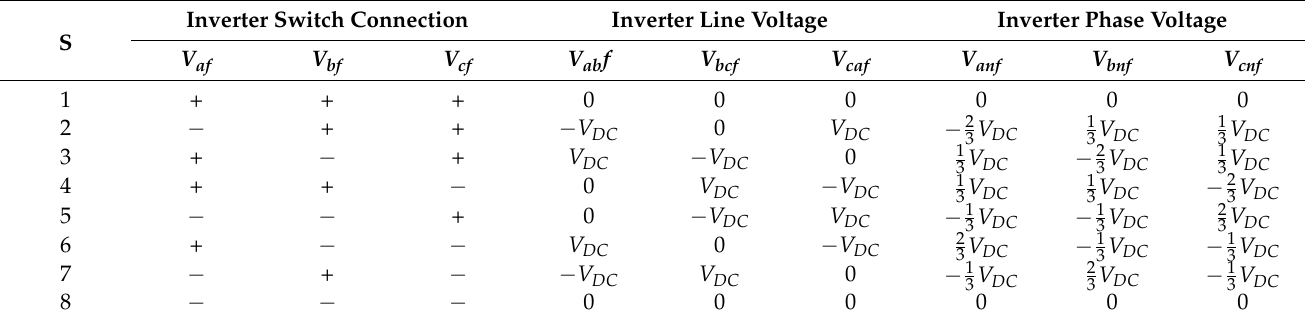
Table 1. Inverter switching operation and output